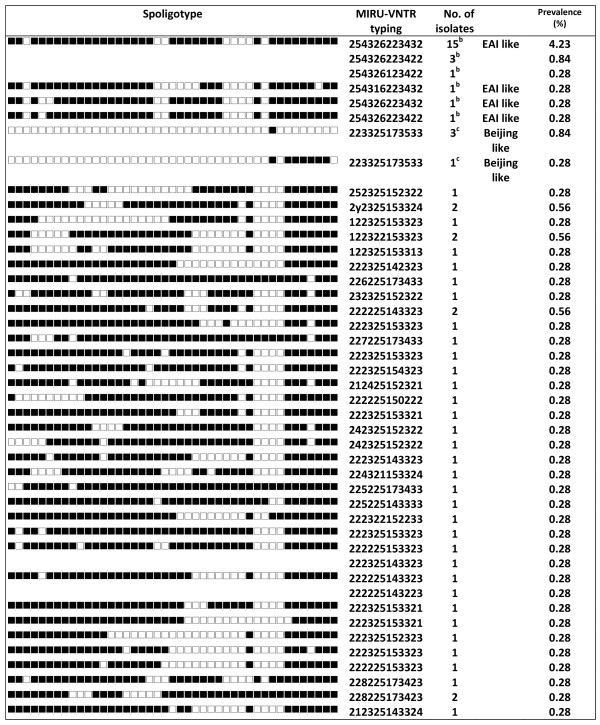
Spoligotypes of 66 orphan strains and clusters of spoligotypes not identified in SpolDB4 by a SIT numbera. a Shared international type (SIT), international spoligotype database SpolDB4 . b TBD1 positive, c RD105 deletion.